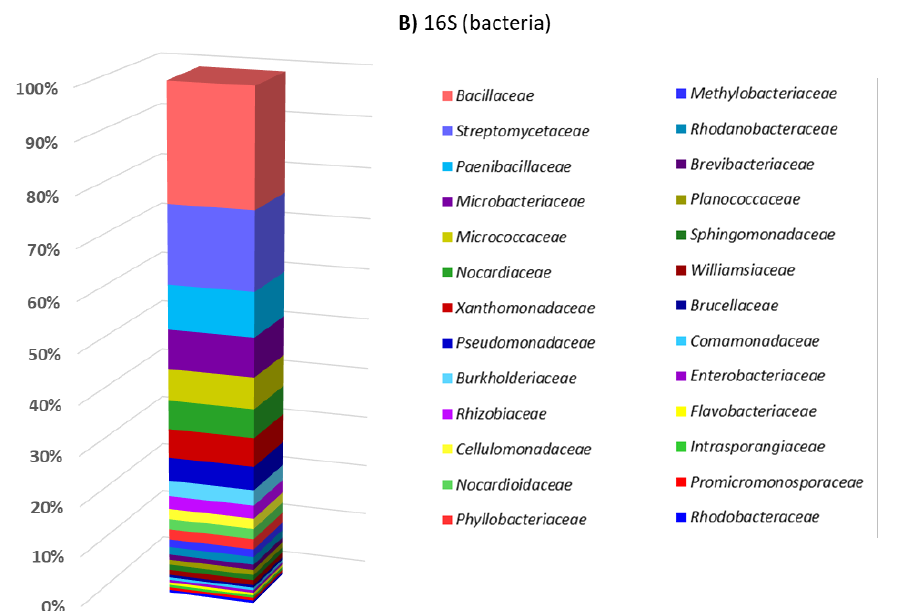
Figure 4. Abundance of microorganisms isolated from wood-decay samples at family level. Each panel presents the family names ordered according to the number of strains isolated from each family: ( A ) fungal families; ( B ) bacterial families.